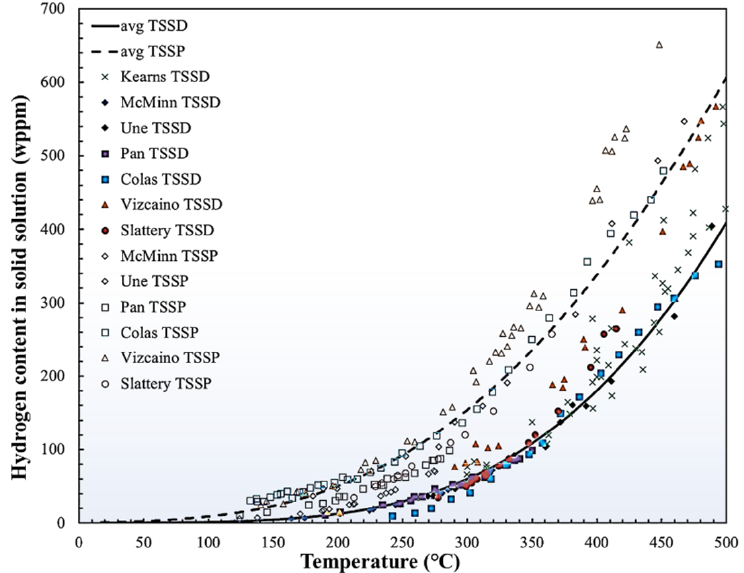
Figure 1. TSSD (solid line) and TSSP (dash line) in Zr and its alloys. Black lines represent average values of TSS based on previous studies [6]. Reprinted with permission from [6]; Copyright 2019 Elsevier.